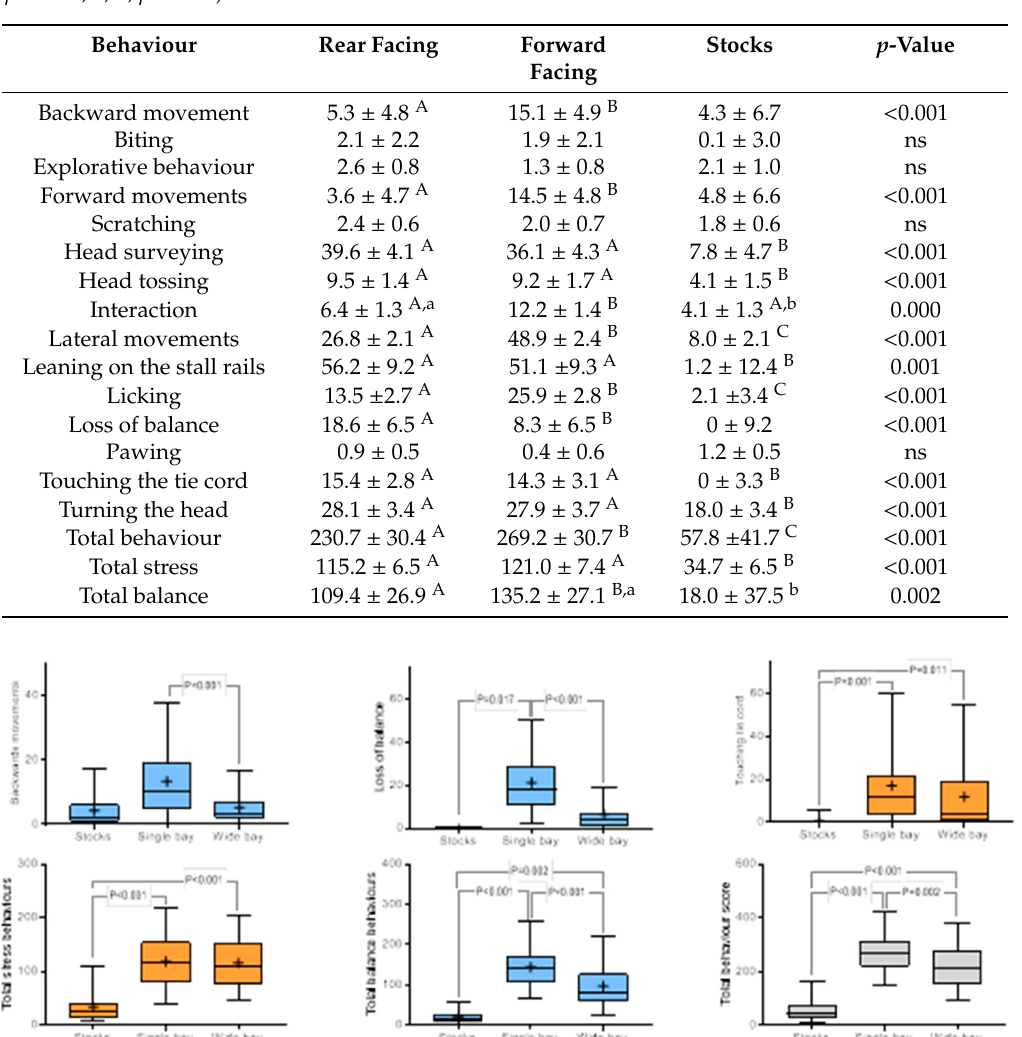
Table 3. The e ff ect of positioning (rear- and forward-facing and stock) on observed behaviours. Data are expressed as the least square mean and standard error (SE), with p -value determined by linear mixed model and Tukey post-hoc testing. Means with di ff erent superscript di ff er significantly (A, B, C, p < 0.01; a, b, p < 0.05).